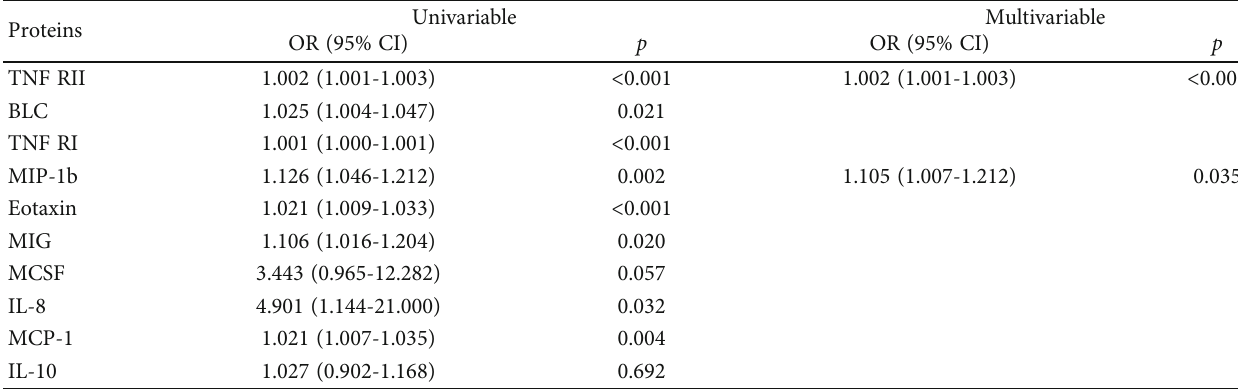
Table 3: Logistic regression analysis in di ff erentiating SLE patients from healthy